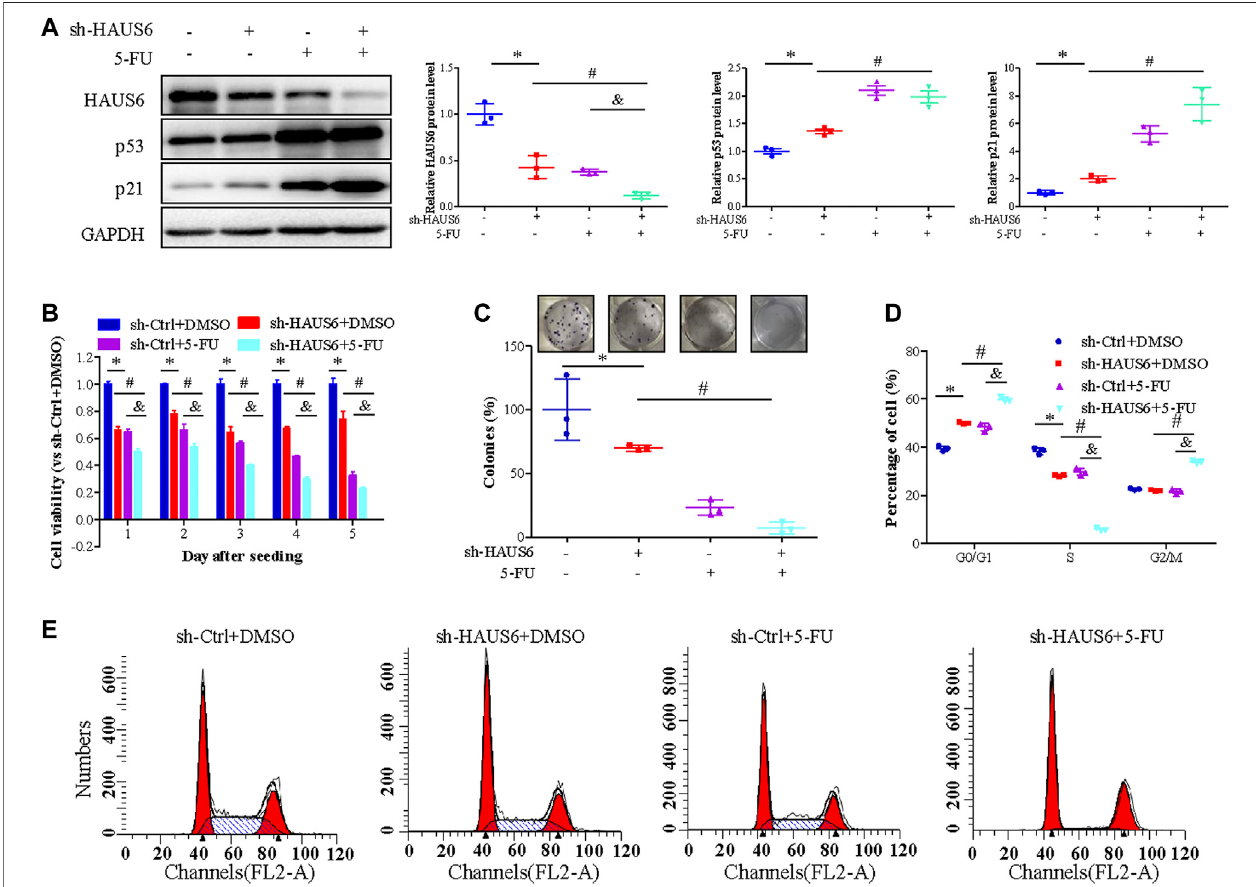
FIGURE 7 | 5-FU treatment enhances HAUS6 knockdown on suppressing CRC cell growth by activating the p53/p21 pathway. (A) HAUS6, p53 and p21 protein levelsinHCT116cellstransducedwithshRNAagainstHAUS6orcontrolshRNAandtreatedwith5-FU,wasdeterminedbywesternblot.GAPDHwasusedasaloading control. Band intensities were quanti fi ed using ImageLab software. Mean ± SD; n (cid:1) 3; * p < 0.05, vs. sh-Ctrl, # p < 0.05 vs. sh-HAUS6+DMSO, & p < 0.05, vs. sh-Ctrl+5- FU, by one-way ANOVA with LSD post hoc test. (B) Viability of HCT116 cells transduced with shRNA against HAUS6 or control shRNA and treated with 2.5 μ M of 5-FUfor24h,wasdeterminedbyCCK-8assay.Resultswerenormalizedtothesh-Ctrlgroup.Mean ± SD;n (cid:1) 6;* p < 0.05,vs.sh-Ctrl,# p < 0.05vs.sh-HAUS6+DMSO, & p < 0.05, vs. sh-Ctrl+5-FU, by one-way ANOVA with LSD post hoc test. (C) Survival of HCT116 cells transduced with shRNA against HAUS6 or control shRNA and treatedwith5-FU, wasassessed bycolonyformationassay.Representativeimagesofcoloniesareshown ontheupperpanel, andcellsurvivalnormalized tothesh-Ctrl groupisshownonthelowerpanel.Mean ± SD;n (cid:1) 3;* p < 0.05,vs.sh-Ctrl,# p < 0.05vs.sh-HAUS6+DMSO,& p < 0.05,vs.sh-Ctrl+5-FU,byone-wayANOVAwithLSD post hoc test. (D,E) Cell cycle distribution of HCT116 cells transduced with shRNA against HAUS6 or control shRNA and treated with 5-FU, was assessed by fl ow cytometry. (D) Therepresentative fl owcytometryplotsareshown. (E) ThepercentagesofcellsinG0/G1,S,andG2/Mphaseareshown.Mean ± SD;n (cid:1) 3;* p < 0.05,vs. sh-Ctrl, # p < 0.05 vs. sh-HAUS6+DMSO, & p < 0.05, vs. sh-Ctrl+5-FU, by one-way ANOVA with LSD post hoc test.